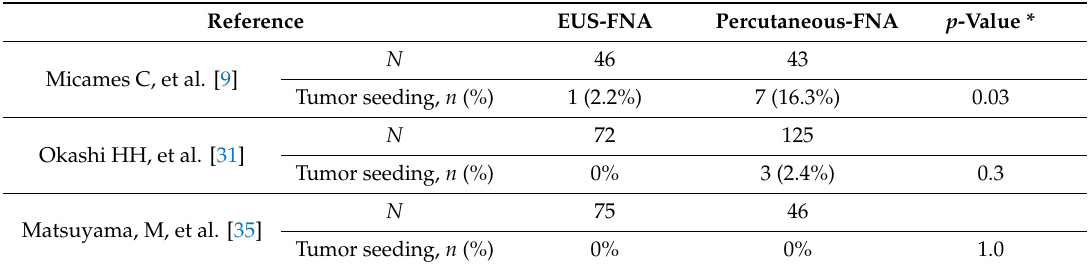
Table 7. Studies comparing tumor seeding between EUS-FNA and percutaneous-FNA. Reference EUS-FNA Percutaneous-FNA p -Value * N 46 43 Micames C, et al. [9] Tumor seeding, n (%) 1 (2.2%) 7 (16.3%) 0.03 N 72 125 Okashi HH, et al. [31] Tumor seeding, n (%) 0% 3 (2.4%) 0.3 Matsuyama, M, et al.